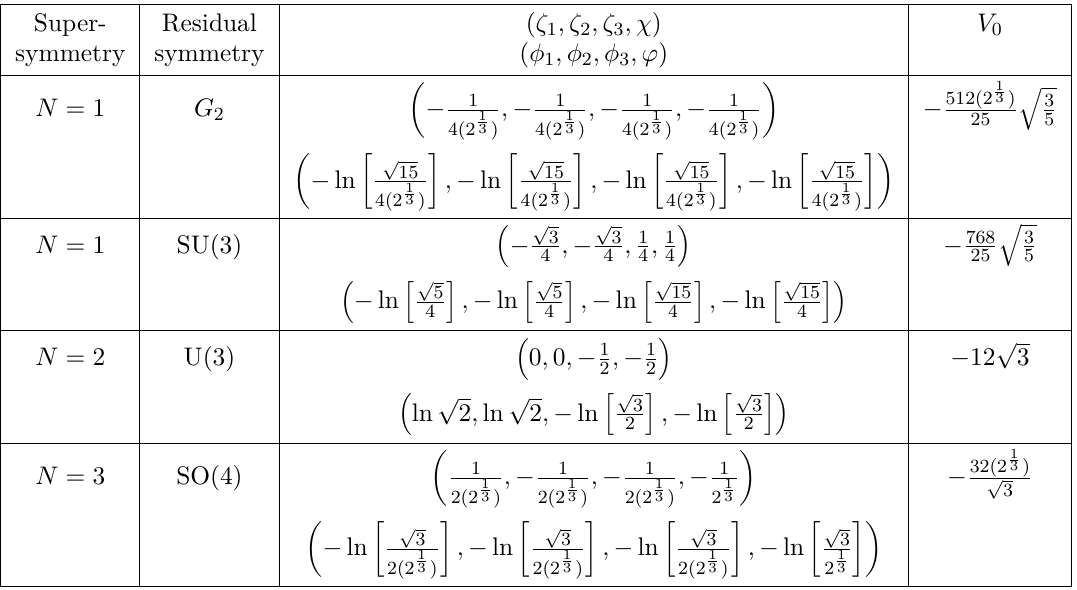
Table 1. Supersymmetic AdS 4 vacua of dyonic ISO(7) gauged supergravity in SO(3) invariant sector with g = m = 1